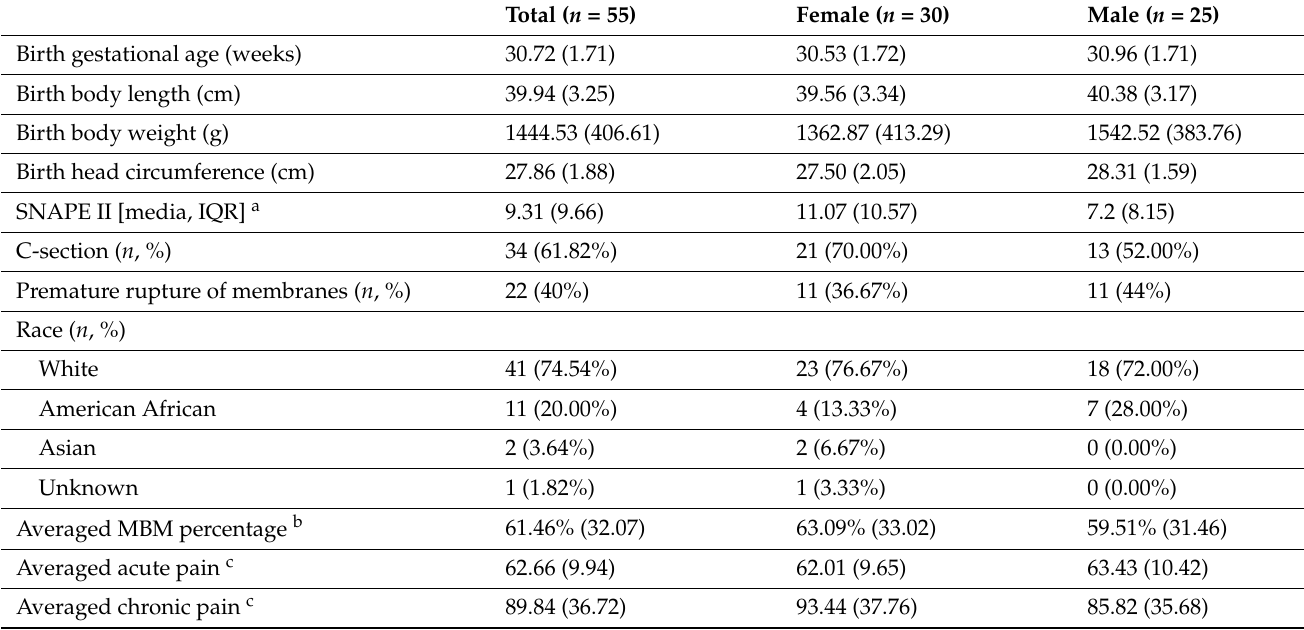
Table 1. Characteristics of the included infants, Mean